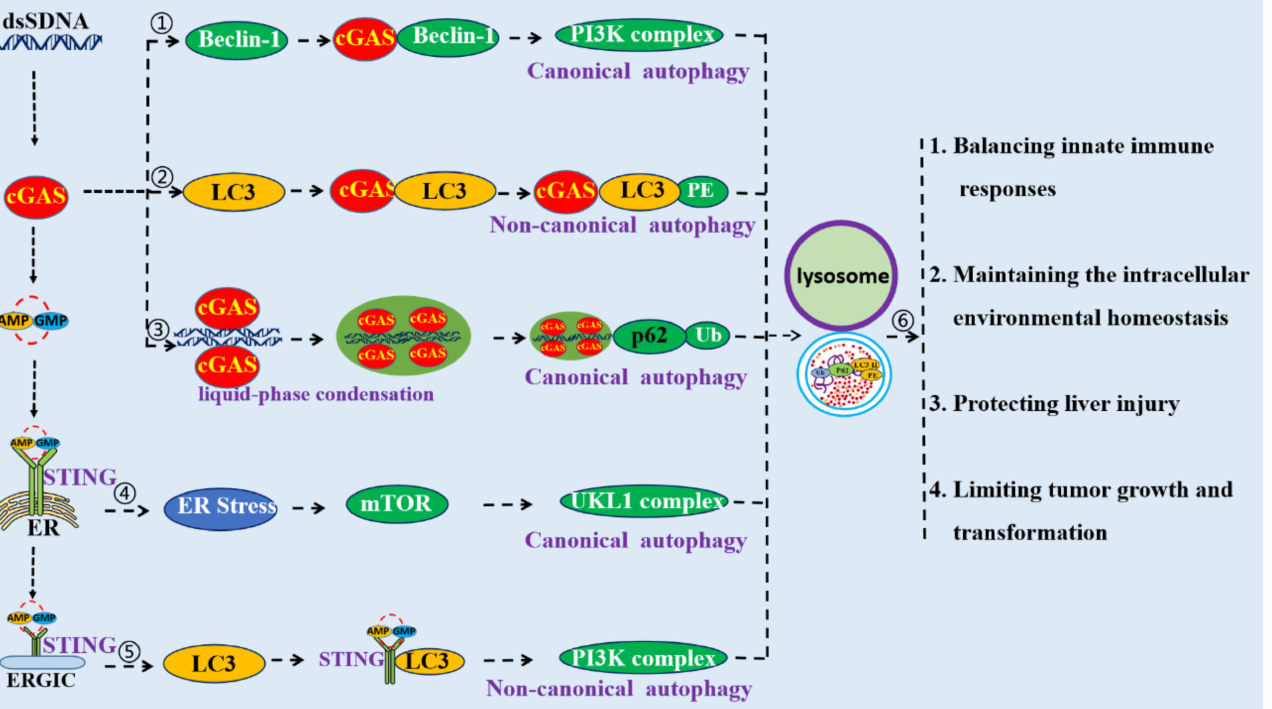
Figure 3. Schematic mechanism of cGAS–STING pathway-mediated autophagy. 1 (cid:13) cGAS could directly interact with Beclin-1 to induce autophagy. 2 (cid:13) cGAS could directly interact with LC3 to induce autophagy. 3 (cid:13) cGAS–dsDNA polymers can form a liquid-phase condensate, which could be an initiator of autophagy. 4 (cid:13) STING could induce autophagy through its interactions with LC3. 5 (cid:13) STING triggers autophagy through the ER stress–mTOR pathway. 6 (cid:13) Autophagy induced by the cGAS–STING pathway is crucial for the modulation of innate immune responses, to maintain intracellular environmental homeostasis, to protect against liver injuries, and to limit cellular transformation and tumor